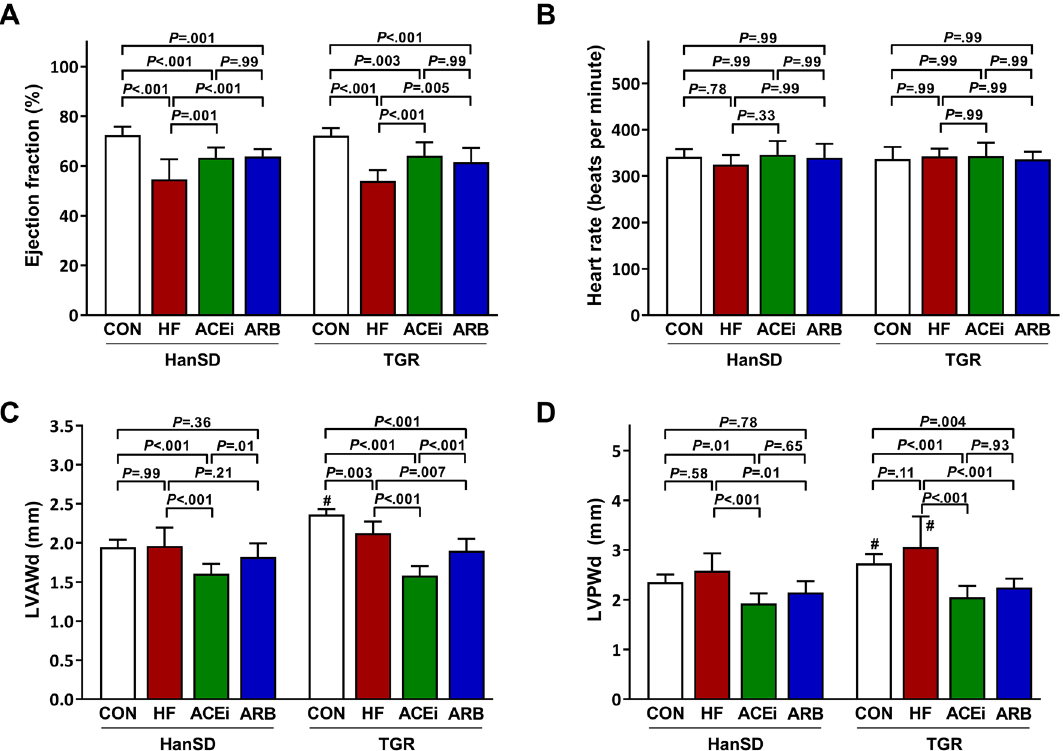
Figure 1. Cardiac ejection fractions ( A ), heart rates ( B ), left ventricle anterior wall dimensions (LWAVd) ( C ) and left ventricle posterior wall dimensions (LVPWd) ( D ) of control (CON), untreated heart failure (HF), ACE inhibitor-treated (ACEi) and AT 1 receptor blocker-treated (ARB) HanSD and TGR rats 20 weeks after sham or ACF operation (5 weeks in HF TGR rats due to high mortality). Data presented as mean ± SD (n = 10 in each group). # P < 0.05 compared to HanSD